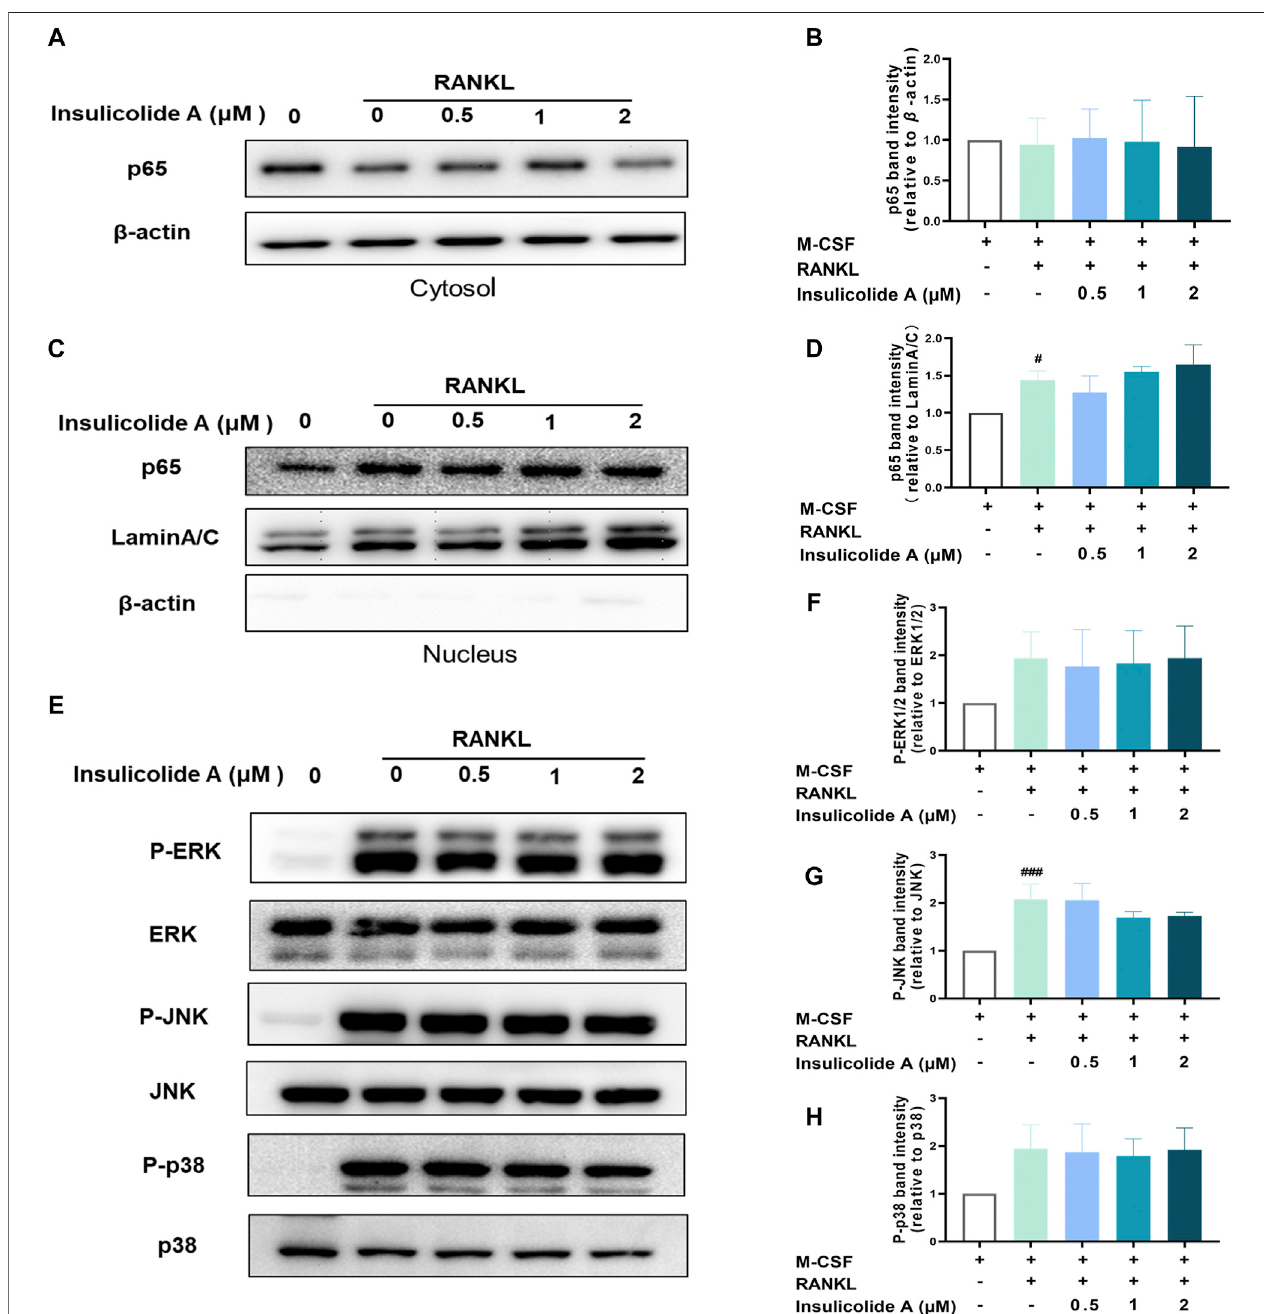
FIGURE 2 | Insulicolide A had little in fl uence on activation of RANKL-induced NF- κ B and mitogen-activated protein kinases (MAPKs). Insulicolide A (0.5 – 2 μ M) in BMMs were fi rst cultured for 4 h, then followed by 100 ng/ml of RANKL stimulation for 30 min. After that, the proteins were harvested and detected by p65,